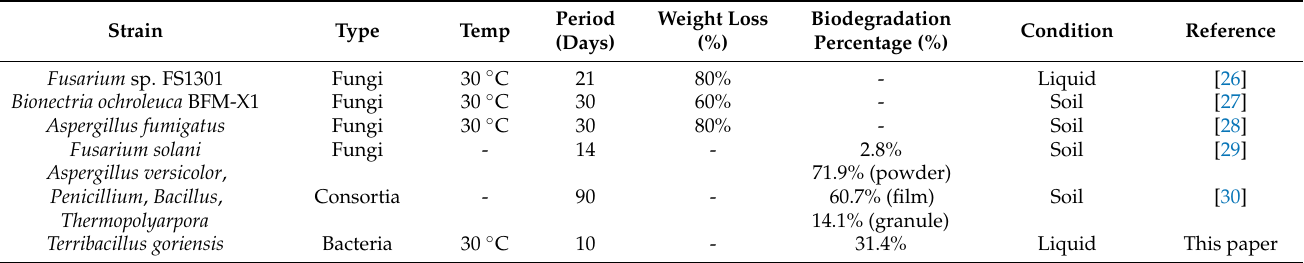
Table 1. List of PBS-degrading strains reported in previous